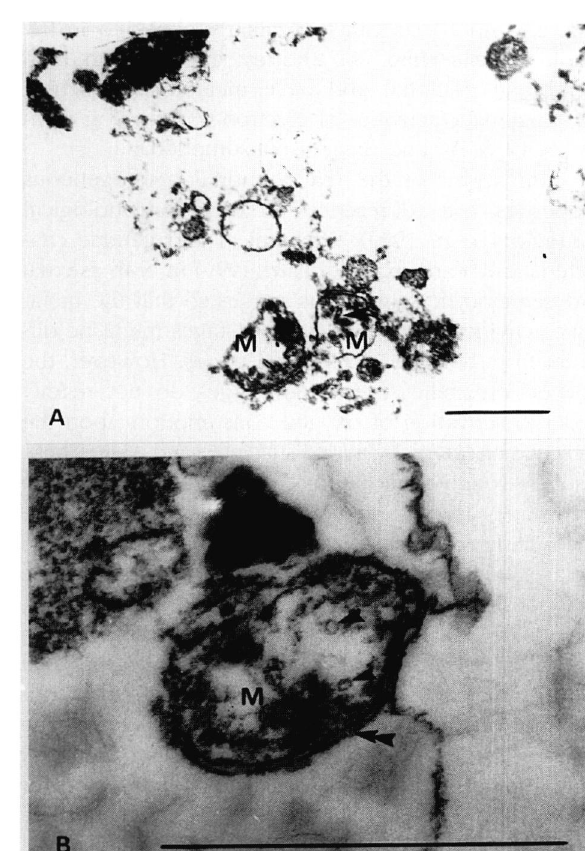
Table II. - Rate of oxygen consumption by asexual and sexual stages of P. falciparum and mouse liver mitochondria.